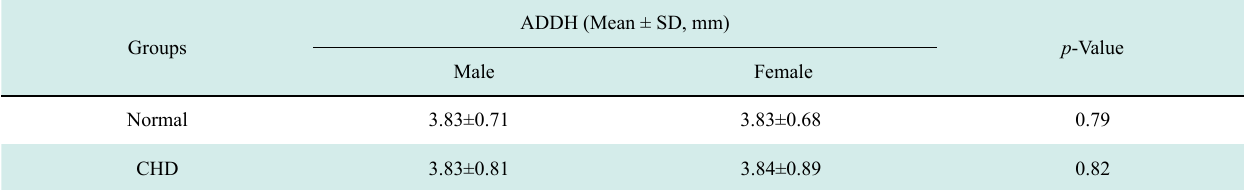
Table 2 Sex differences between fetal ADDH in CHD and normal groups Groups